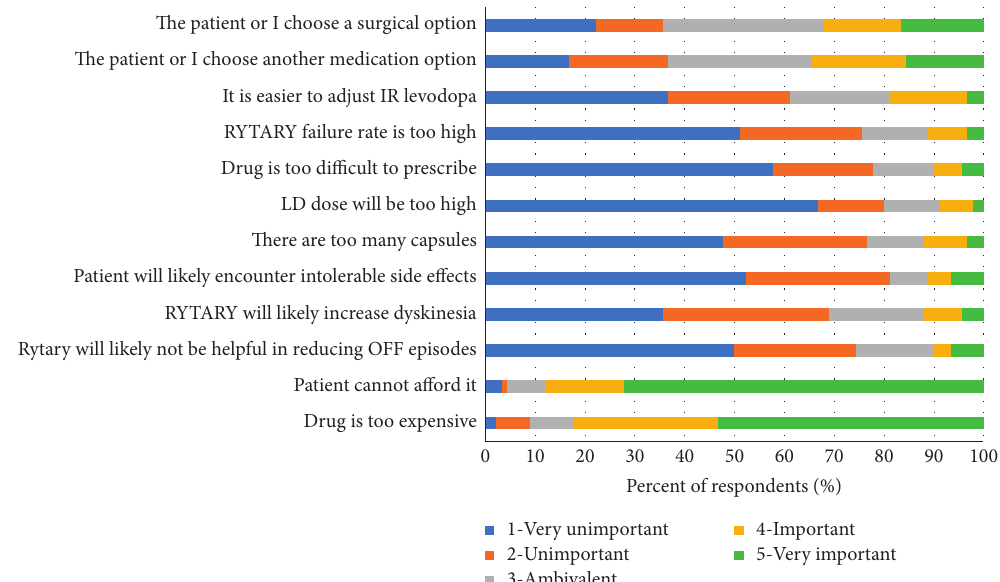
Figure 5: Importance rating of reasons why CD-LD ER would not be used in a patient with OFF